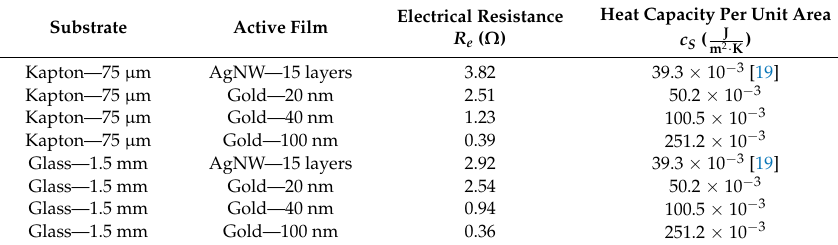
Table 1. Properties of the thermoacoustic loudspeaker samples.